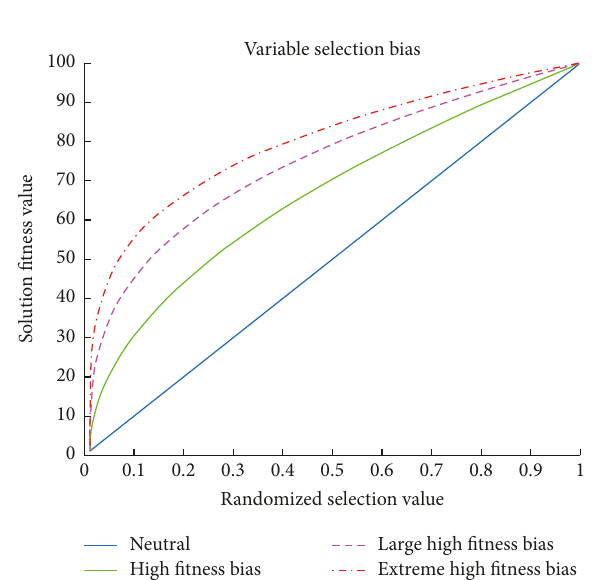
Figure 4: Four selection schemes for choosing parent chromo- somes. Arandomized value in therange (0, 1)ischosen on the 𝑥 -axis and solution associated with the corresponding fitness value is used as a parent. The most extreme bias gives solutions in the bottom half of the ranking a combined chance of less than 10% of being